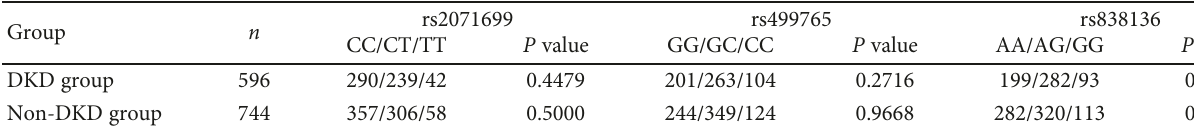
Table 1: Hardy-Weinberg equilibrium tests.